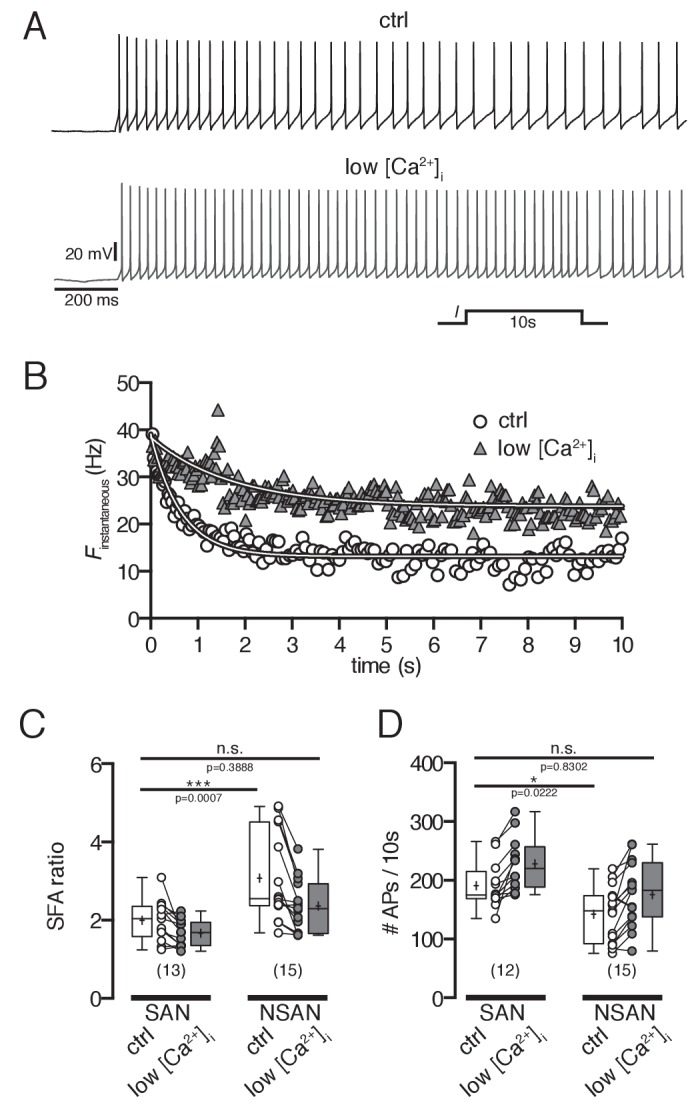
Spike frequency adaptation in POMC neurons depends on intracellular Ca2+ concentrations.(A and B) Original recording (A) and corresponding plot of the instantaneous spike frequency (B) of a silent POMC neuron showing the SFA during a 10 s depolarizing current pulse at normal and reduced [Ca2+]I. Reducing [Ca2+]i decreased the SFA. (C) SFA ratios of spontaneously firing and silent POMC neurons at different [Ca2+]i. In silent POMC neurons, the SFA is higher compared to firing POMC neurons. Reducing [Ca2+]i in silent neurons decreases SFA ratios to levels of firing neurons (ANOVA with Bonferroni corrections). (D) The number of action potentials during the 10 s depolarizing current pulse is smaller in silent compared to firing POMC neurons. Reducing [Ca2+]i increased the number of APs in silent neurons to the level of firing neurons (ANOVA with Bonferroni corrections). SFA, spike frequency adaptation; SAN, spontaneously active neuron; NSAN, not spontaneously active neuron (F < 0.5 Hz). *p<0.05, ***p<0.01.